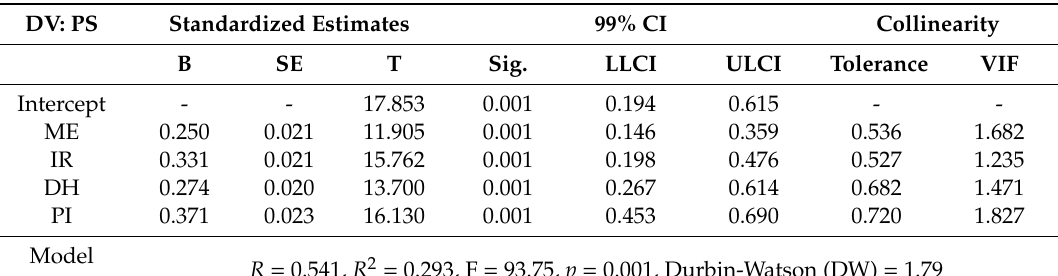
Table 8. Multiple regression